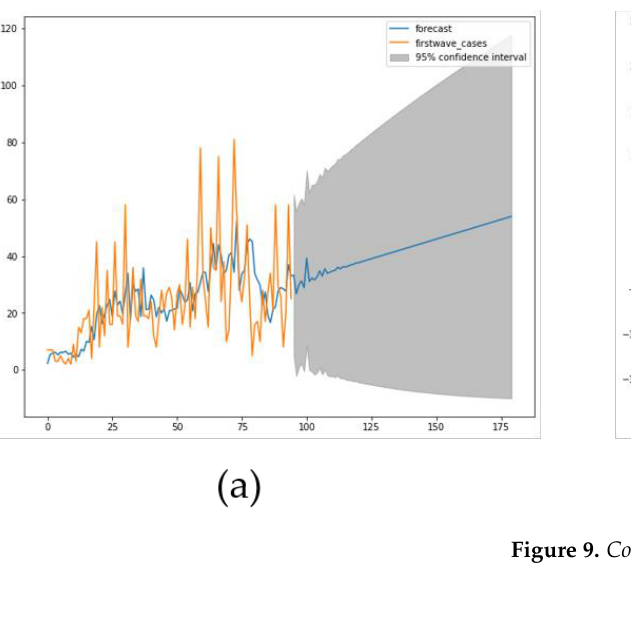
Figure 8. ( a ) Second wave moving average and standard deviation of new cases (left) and ( b ) autocorrelation curve for Mali (right). ( c ) Second wave moving average and standard deviation of new cases (left) and ( d ) autocorrelation curve for Slovenia (right).